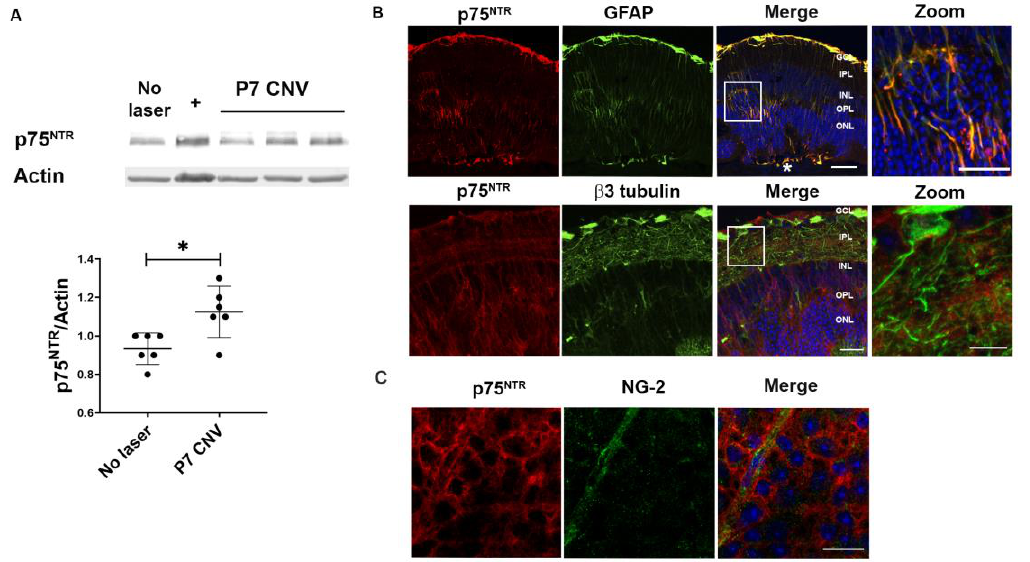
Figure 2. Activated macroglial cells express p75 NTR after the laser around the injured area in the retina. p75 NTR protein co-localizes with GFAP-positive activated macroglia in CNV mice retinas, 7 days after laser. Tissue extracts and retina sections were prepared and evaluated by Western blot and by IHC. ( A ) Representative Western blot of total retinas homogenates prepared from WT mice without CNV, or 7 days after laser injury. (+) Correspond to a positive control (hippocampus E19 M2). Actin was used as loading control. Bands were quantified by densitometric analysis, and p75 NTR /actin ratio is represented in the bar graph expressed as units relative to control. Bars denote the mean ± SD from triplicate experiments, n = 6 mice/group. The asterisks show statistical differences respect to control. * p < 0.05. ( B ) Representative confocal images of WT CNV mice retinal cryosections, 7